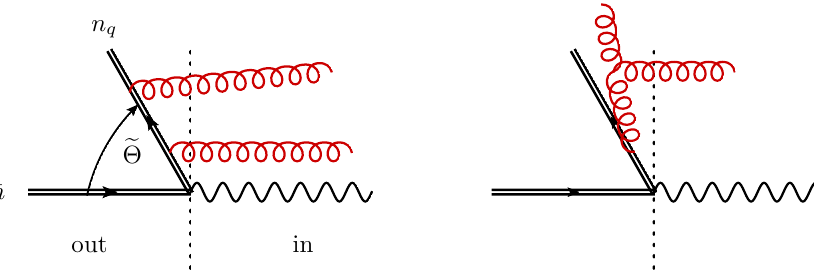
Figure 10 . Kinematics and example diagrams arising in the the parton shower computation of U LL ( e Θ , t ) . We use the rescaling invariance (7.1) and Lorentz invariance of the shower to evaluate q the function in a frame where ¯ n and n γ are back-to-back and the isolation cone covers the entire right hemisphere. The left diagram shows an example of a two-loop global contribution, the right one a non-global